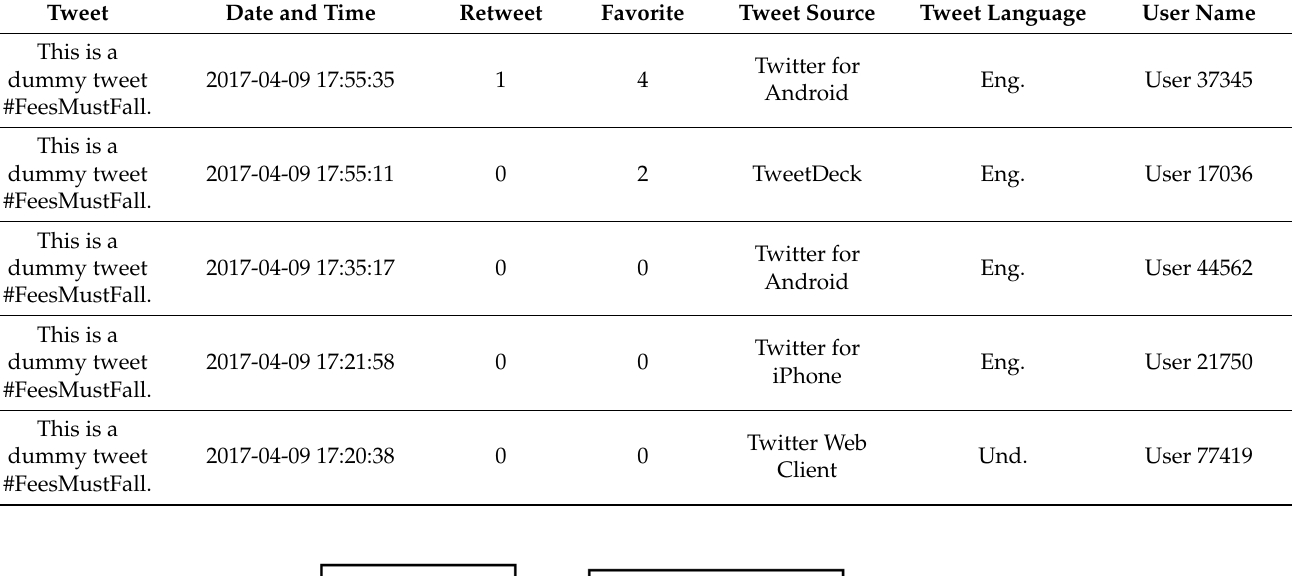
Table 1. A sample of the data with Tweets and usernames anonymized.